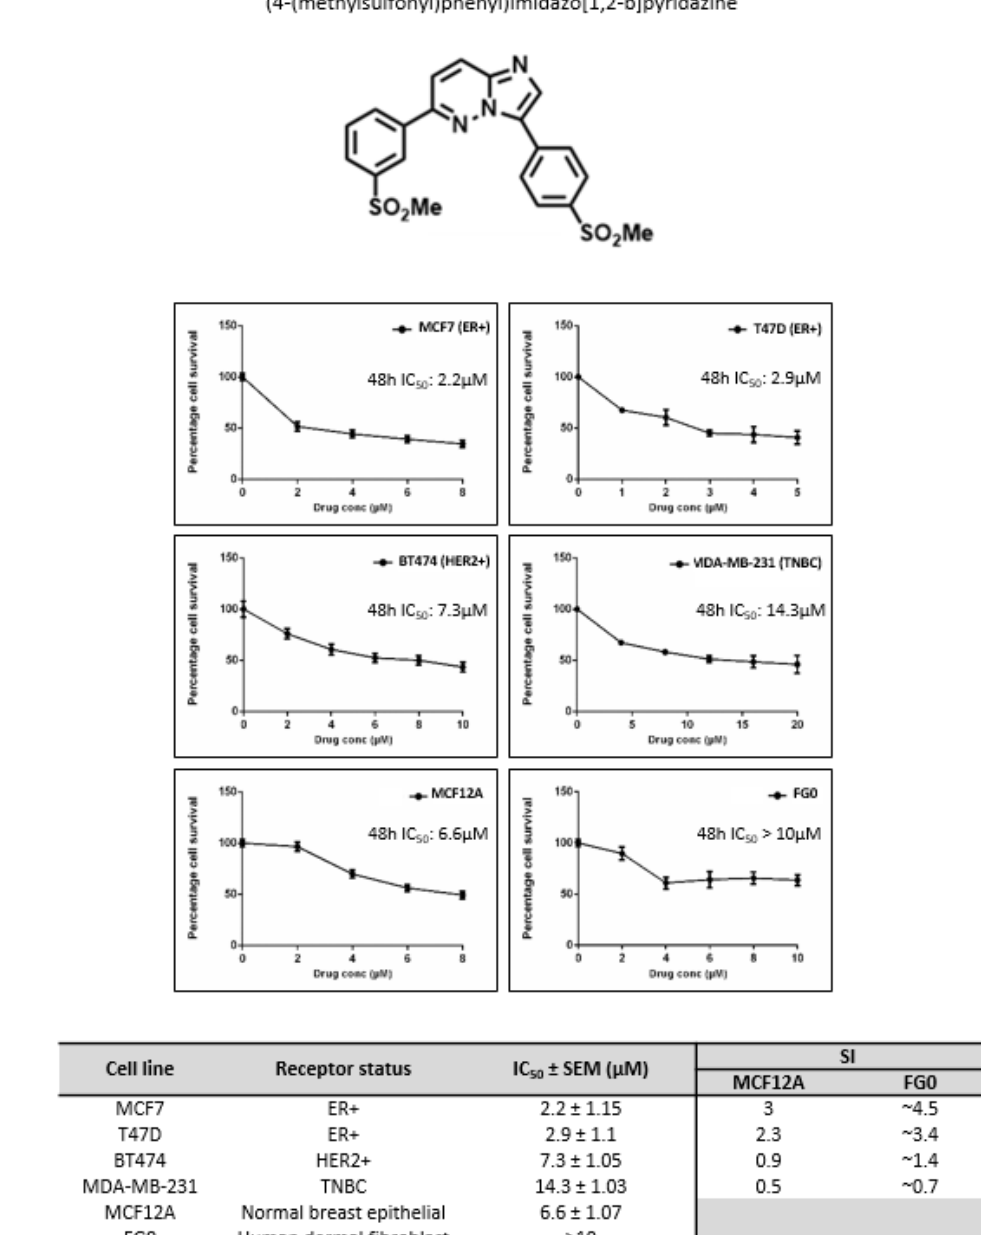
Figure 2: MMV652103 exerts selective cytotoxicity in estrogen receptor positive (ER+) breast cancer cells. ( A ) Chemical name and structure of MMV652103. ( B ) MTT cell viability assays of MCF7 and T47D (ER+), BT474 (HER2+) and MDA-MB-231 (TNBC) breast cancer cell lines, MCF12A (normal breast epithelial cell line) and FG0 (human skin fibroblast cells), treated with a range of MMV652103 concentrations (1–20 µM) or vehicle (DMSO) for 48 h. Graphs show mean cell viability as a percentage of vehicle control ± SEM for each concentration of MMV652103 determined from three independent experiments performed in quadruplicate. ( C ) Tabled summary of the IC 50 concentrations of MMV652103 obtained for each cell line ± SEM, together with selectivity indices (SIs) which were determined for each breast cancer cell line by dividing the IC 50 of each non-malignant cell line by the IC 50 of the respective breast cancer cell